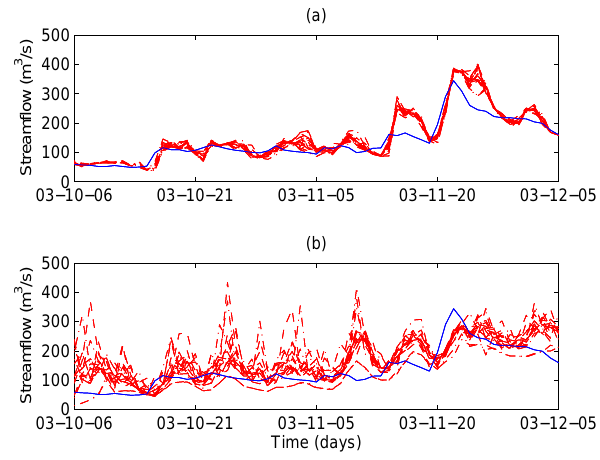
Fig. 5. Raw streamflow ensemble forecasts for Maniwaki sub- catchment, (a) 48h ahead and (b) 240h